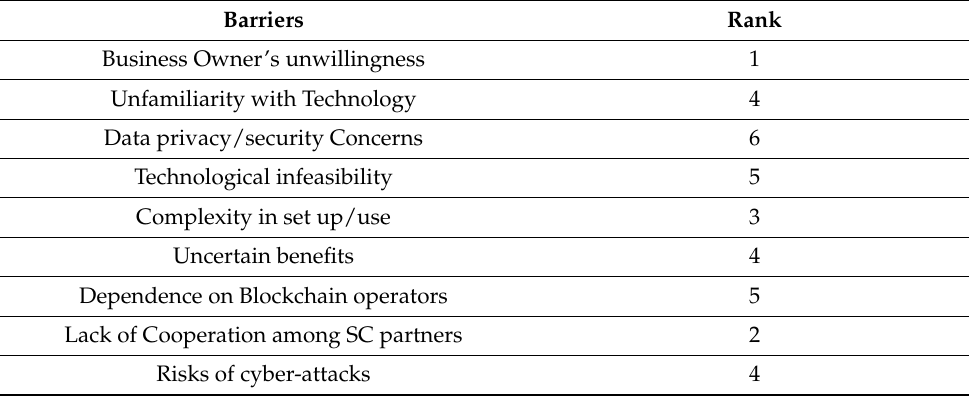
Table 13. Rank of